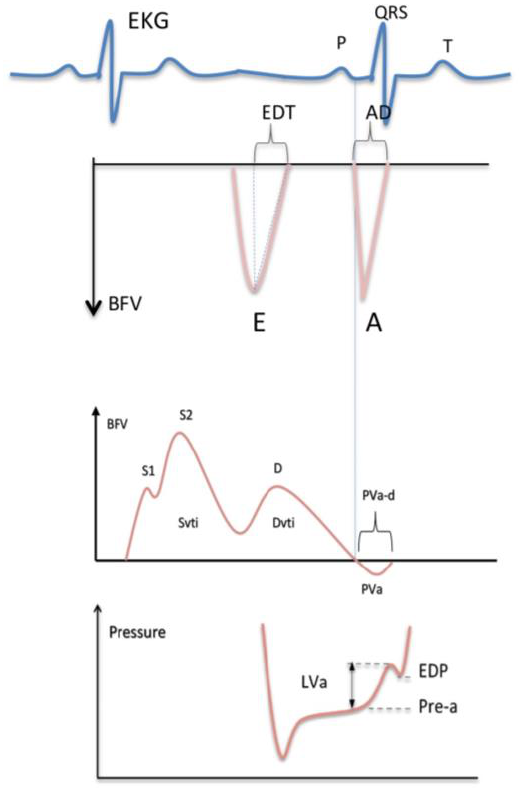
Figure 1. Measurement of the mitral flow velocity ( top ) and the pulmonary venous flow velocity ( middle ) with the left ventricular diastolic pressure curve ( bottom ). EKG = electrocardiogram; QRS = EKG waves related to ventricular depolarization; BFV = blood flow velocity; E = peak velocity of the early mitral flow; EDT = deceleration time of the early mitral flow; A = peak velocity of the late mitral flow; AD = duration of the late mitral flow; S = peak systolic velocity of the pulmonary venous flow; Svti = systolic velocity integral of the pulmonary venous flow; D = peak diastolic velocity of the pulmonary venous flow; Dvti = diastolic velocity integral of the pulmonary venous flow; PVa = peak velocity of the reverse flow at atrial contraction; PVa-d = duration of the reverse flow; LVa = increase in the ventricular pressure due to atrial systole; Pre-a = pressure before atrial contraction; EDP = left ventricular end-diastolic pressure. The vertical dashed lines indicate the simultaneous start of the antegrade flow through the mitral valve and the retrograde flow into the pulmonary vein at atrial contraction; the mitral waves ( top ) are negative since transmitral flow is away from the transducer from a transesophageal approach.